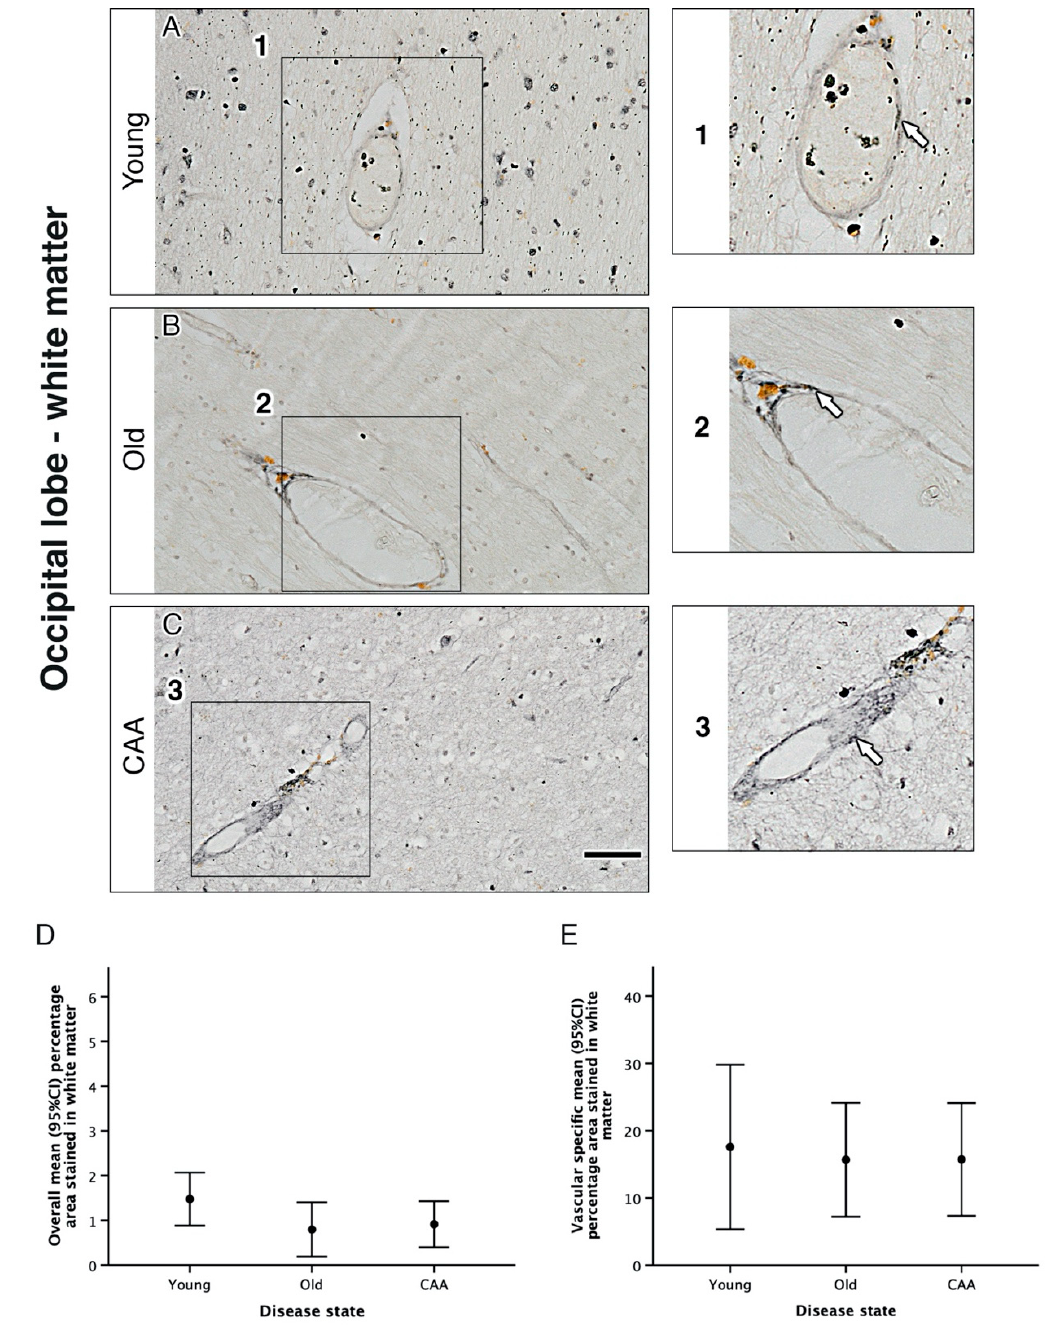
Figure 2. The pattern of distribution of the α 1A -AR in the white matter of the occipital lobe. Neuronal staining appeared most intense in young cases ( A ) and appeared to decrease in both old ( B ) and CAA cases ( C ). In all cases, α 1A -AR immunoreactivity was observed in vessel walls (enlarged boxes 1, 2 and 3). There were no significant differences observed in overall percentage area staining ( D ) or the percentage of the vessel wall positive for α 1A -AR in white matter ( E ). Graphs depict the mean ± 95% confidence intervals, n = 5. Scale bar 50 µm.